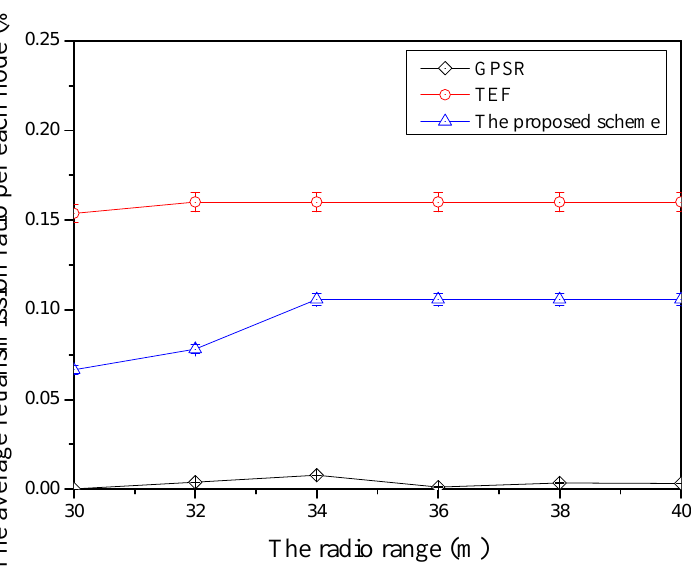
Figure 12. The comparison of the average retransmission ratio per node according to radio